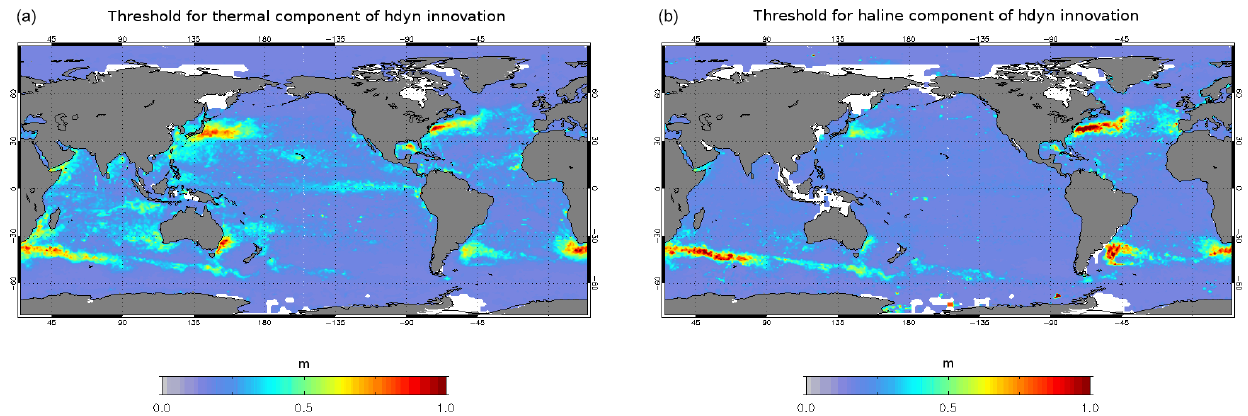
Figure 2. Thresholds used for QC2 for the thermal component of dynamical height innovation ( a , threshold T ) and for the haline component of dynamical height innovation ( b , threshold S ) . Units are